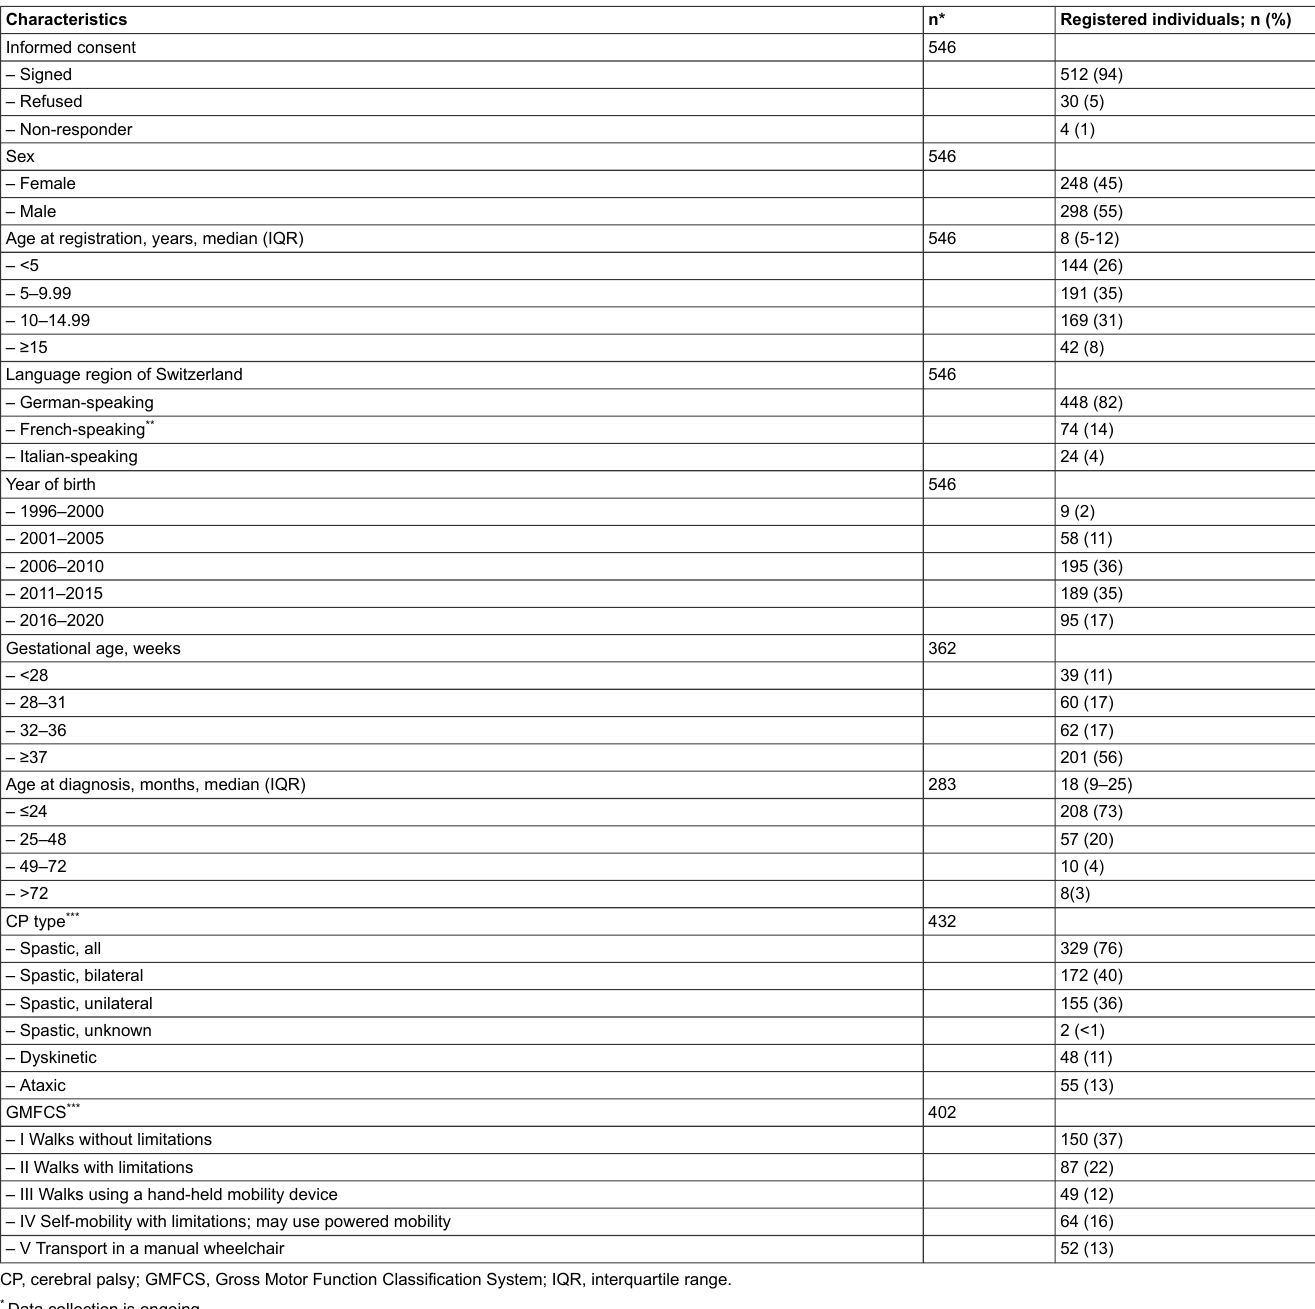
Table 2: Characteristics of study participants in the Swiss Cerebral Palsy Registry (n = 546, status at 31.08.2021).